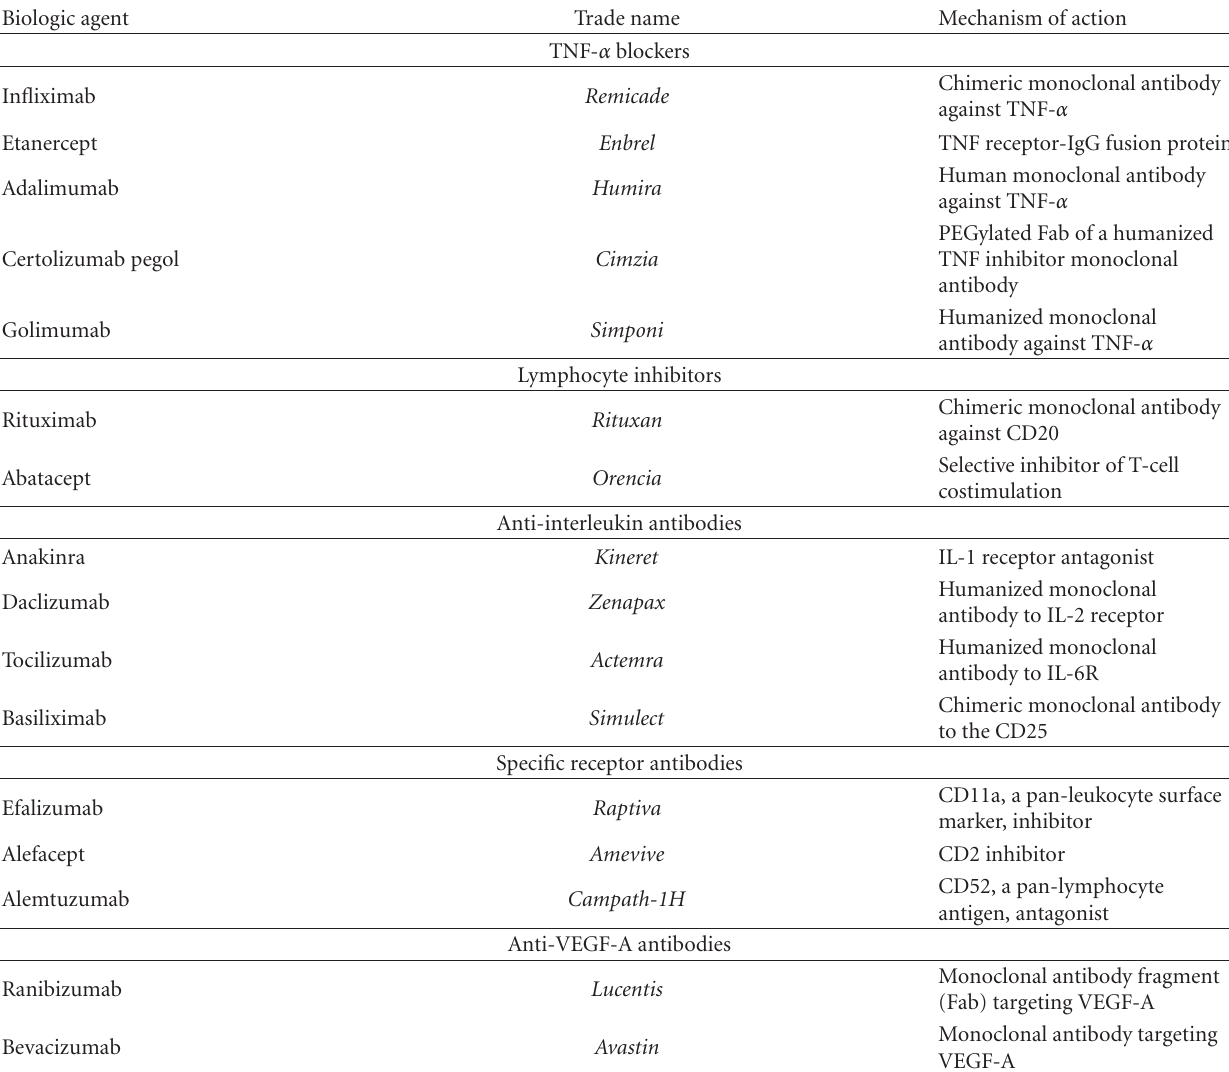
Table 1: Biologic